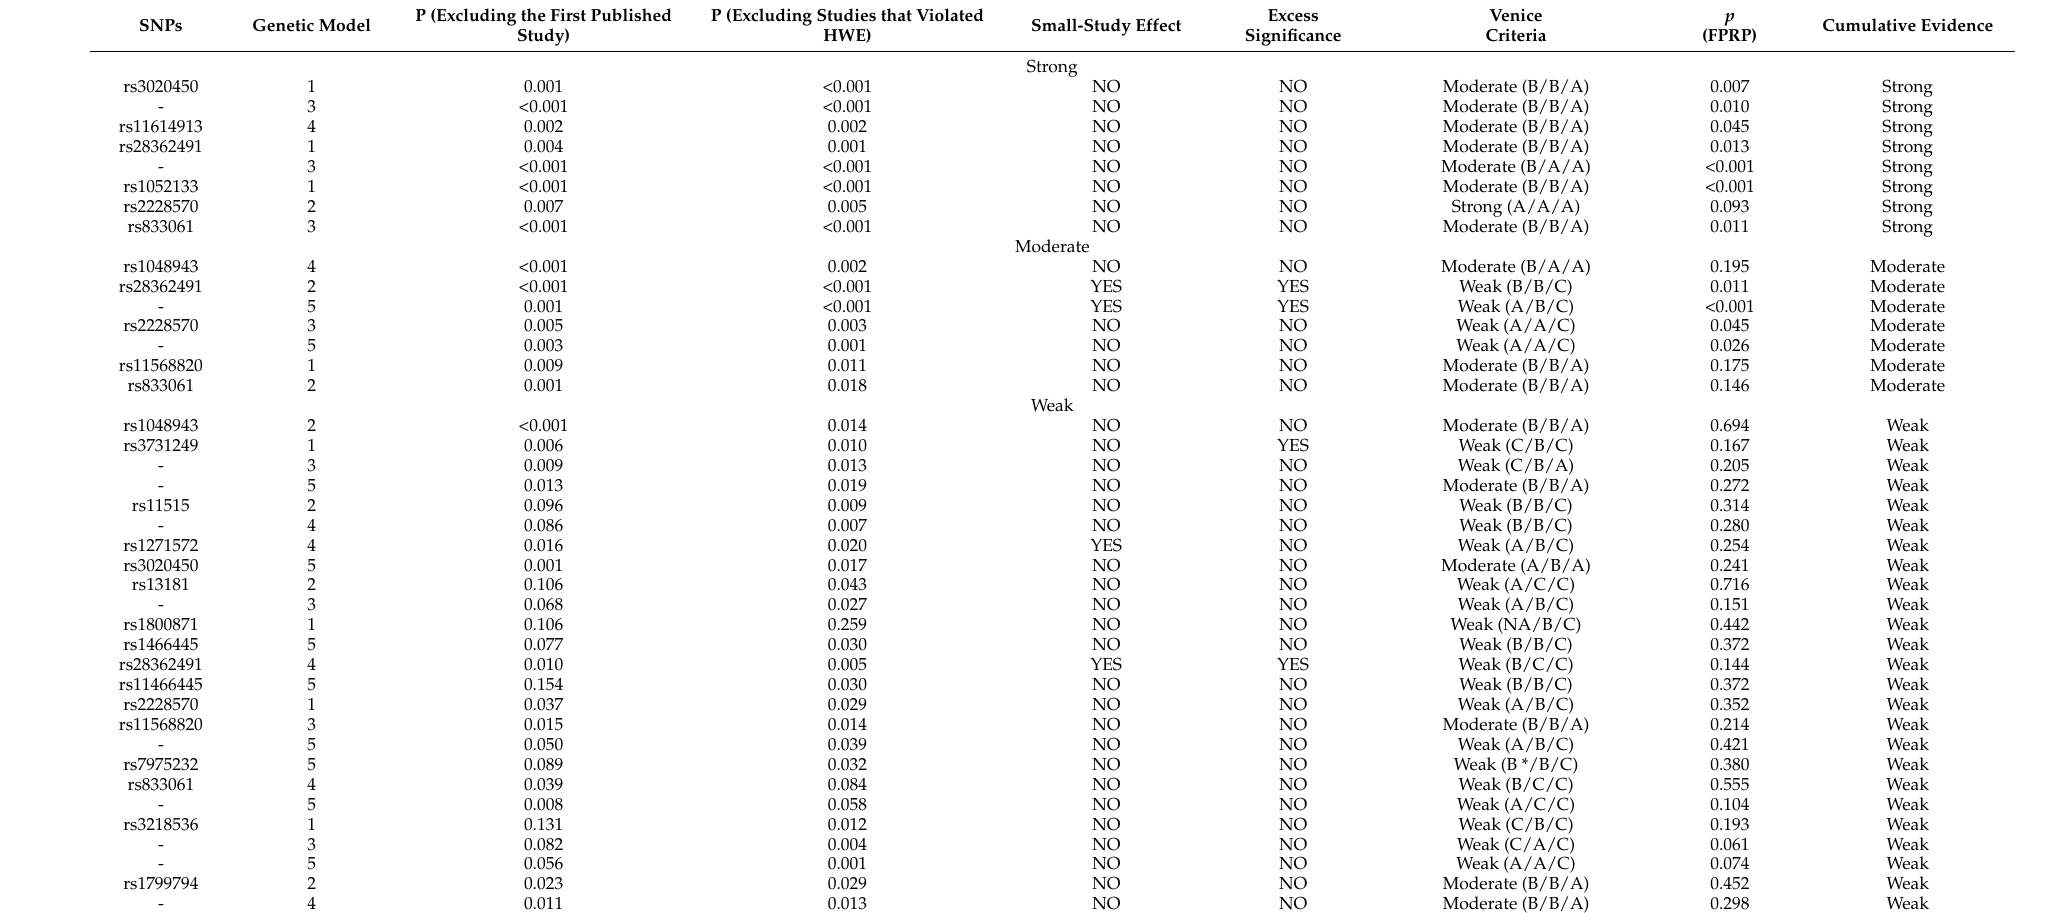
Table 2. Cumulative evidence details of SNPs with nominal statistical